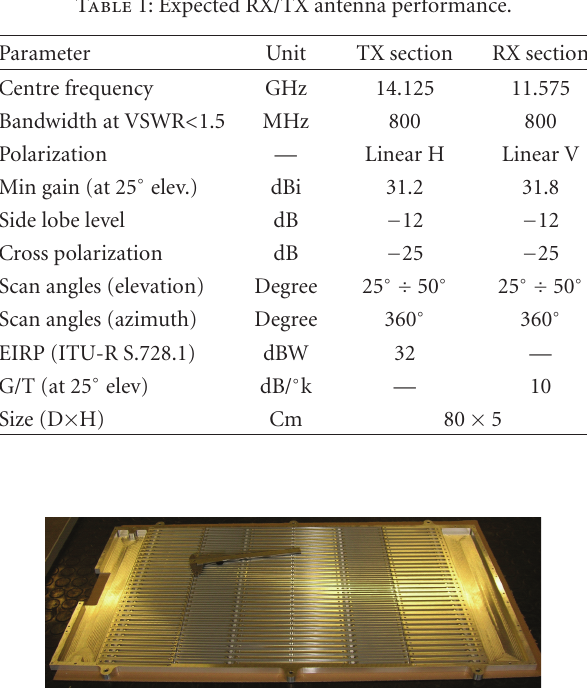
Figure 5: Fabricated waveguide combining